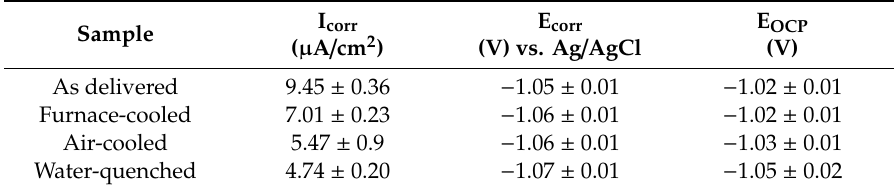
Table 2. The electrochemical parameters obtained for as delivered samples, as well as samples heat-treated at 300 ◦ C and subjected to di ff erent cooling